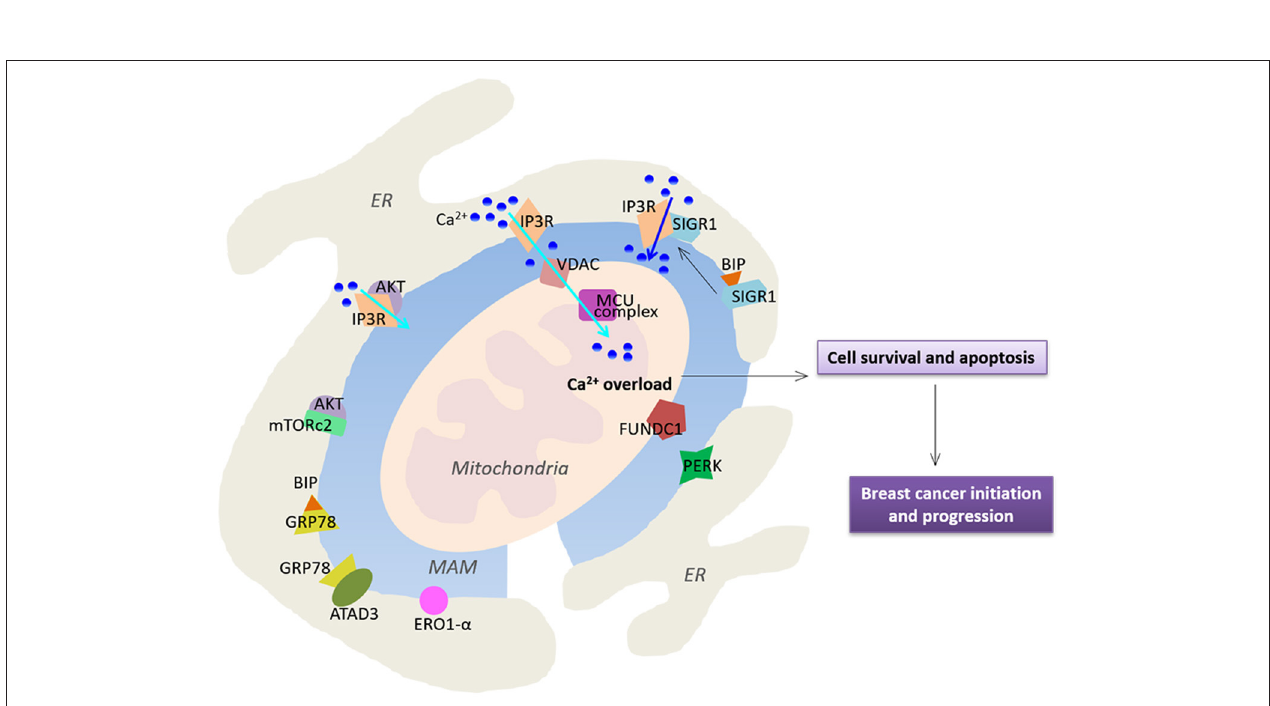
FIGURE 2 | Functional alterations of MAMs in breast cancer. MAMs-resident proteins play a crucial role in regulation of Ca 2 + homeostasis, thereby affecting cell survival and apoptosis. Cyan arrows highlight Ca 2 + transport while the blue arrow indicates a larger Ca 2 + fluxes. See text for further details.